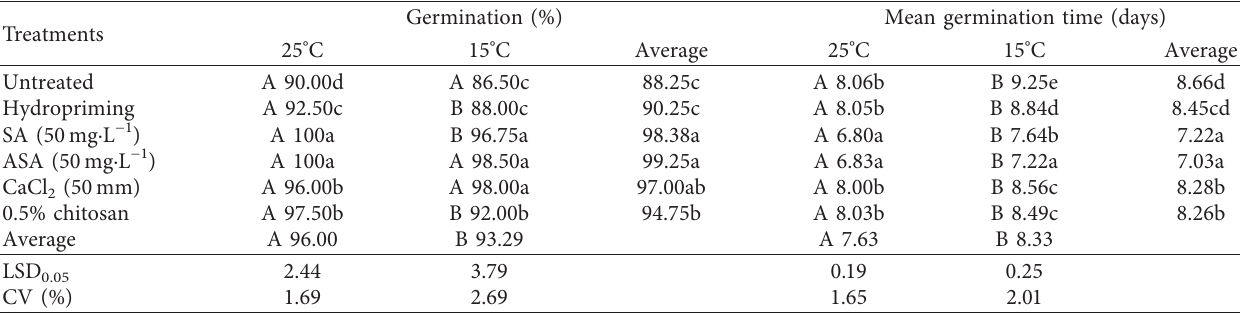
Table 1: Effects of seed priming on germination percentage and mean germination time of Tainan 9 peanut seeds at 25 ° C and 15 ° C before 9 months of storage.